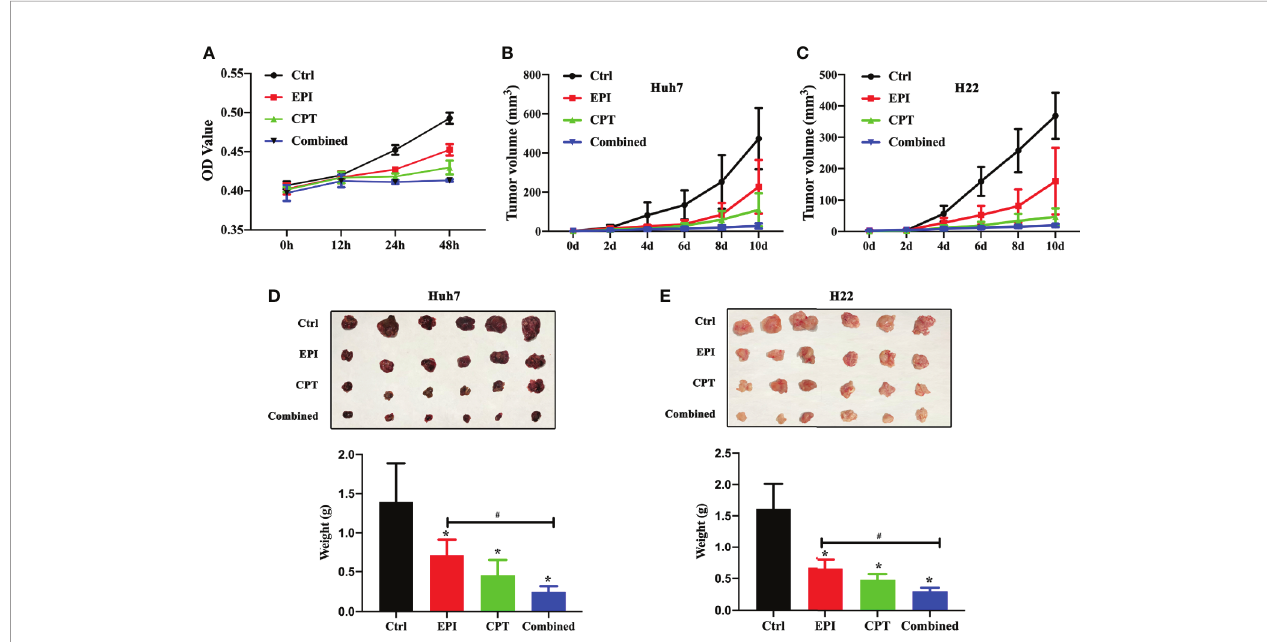
FIGURE 3 | Down-regulation Nrf2 by CPT suppressed proliferation of Huh7 cells and tumor growth of Huh7 and H22. (A) Proliferation of Huh7 cells was measured and presented as OD value at 0, 12, 24, and 48h. (B, C) Tumor volume of Huh7 cells (B) and H22 cells (C) . (D, E) The tumor weight of Huh7 cells (D) and H22 cells (E) . *P < 0.05, # P <